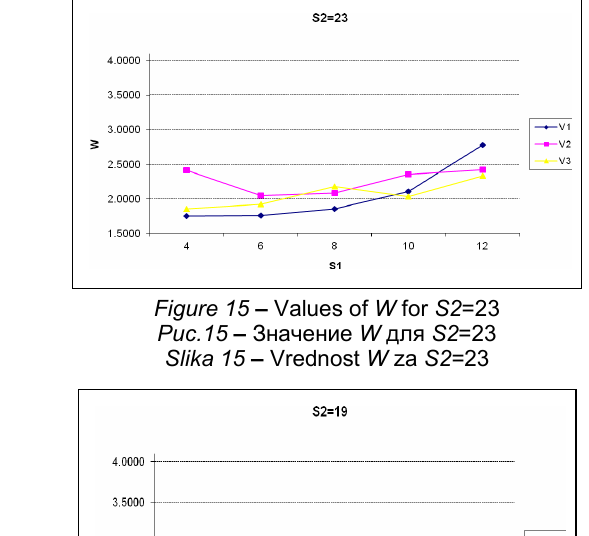
Figure 16 – Values of W for S2 =19 Рис .16 – Значение W для S2 =19